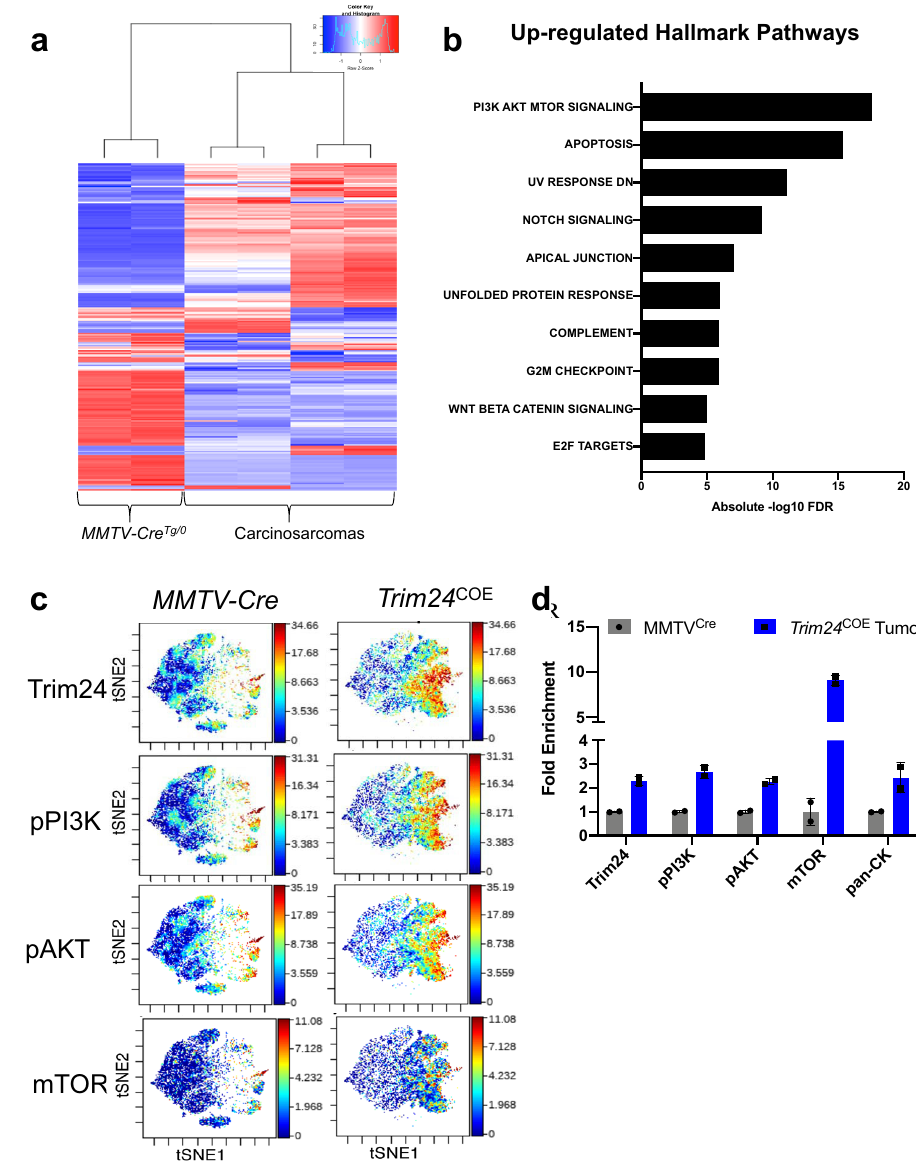
Fig. 4 Protein pro fi ling shows TRIM24 over-expression correlates with increased PI3K-AKT-mTOR signaling. a Reverse Phase Protein Array shows distinct protein pro fi les between metaplastic carcinosarcoma tumors driven by TRIM24 compared to MMTV-Cre Tg/0 mammary glands shown by heatmap. b The bar plot represents up-regulated hallmark pathways on proteins identi fi ed by RPPA. X-axis represents − log 10 FDR values for each hallmark pathways. c Validation of protein expressions by CyTOF where allograft tumors derived of TRIM24 overexpressing metaplastic carcinosarcoma primary cell lines where compared to MMTV-Cre Tg/0 mammary glands for TRIM24, phospho-PI3K, phospho-AKT, and mTOR. d Quanti fi cation of overall median protein expression in Trim24 COE allograft tumors compared to MMTV-Cre Tg/0 mammary glands ( n = 2 biologically independent samples). Data represented as mean with using protein loading controls 31 . Normalized protein loading and transformed linear values were used to determine fold change and later log 2 transformed fold change values (Supplementary Data 7). The normalized values were also used to generate a heatmap representation of differentially produced (57 up- regulated and 47 down-regulated) proteins in Trim24 COE tumors compared to control mammary glands (Fig. 4a). We converted protein probes to gene identi fi ers (IDs) to perform GSEA and determine hallmark pathways of differentially expressed proteins 25 . Based on RPPA, we identi fi ed PI3K-mTOR signaling, apoptosis, UV response and Notch signaling as the top up- regulated pathways (Fig. 4b). mTOR complex pathway and G2/M